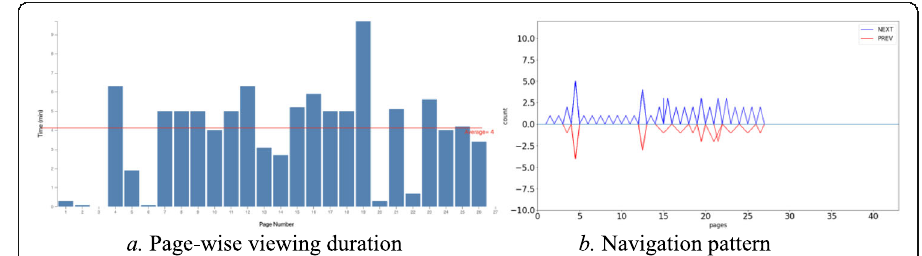
Fig. 12 a Page-wise viewing duration. b Navigation